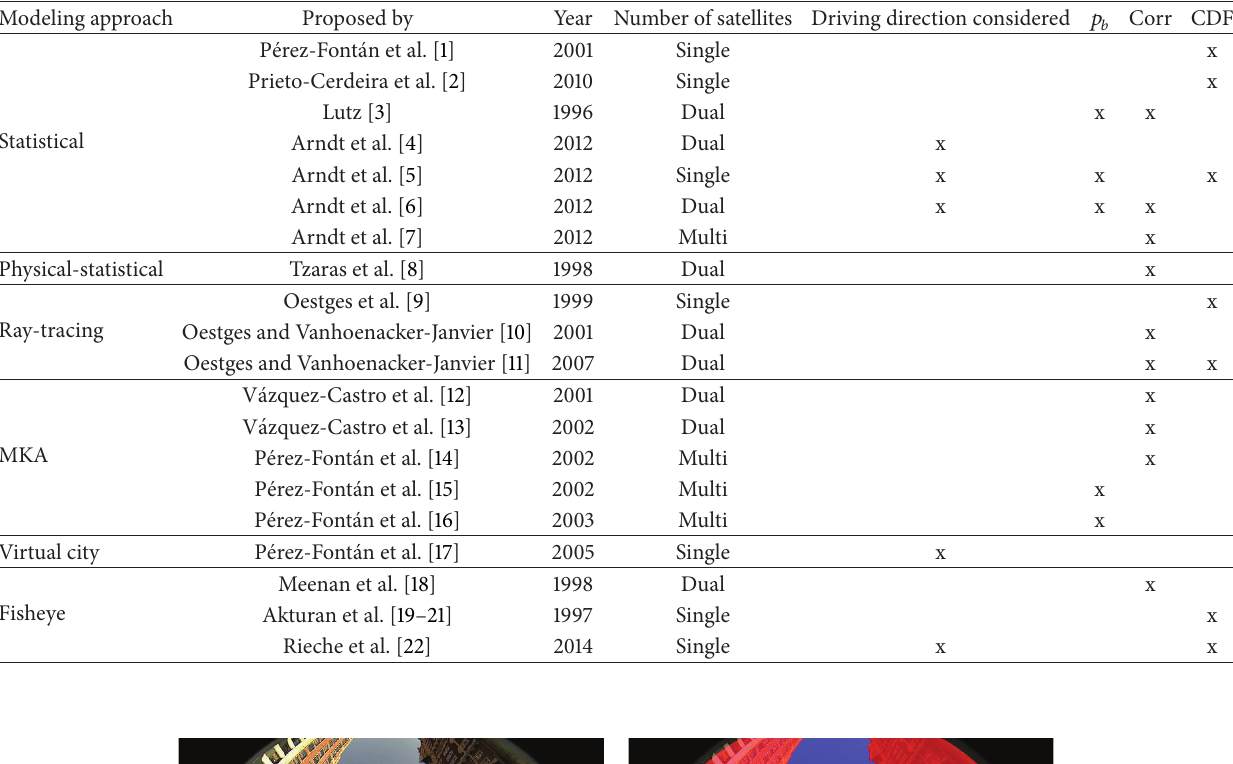
Table 1: Statistical and physical-statistical LMS channel models are compared with respect to the modeling approach, the number of satellites, considering the driving direction of the terminal, considering the correlation coefficient (Corr) and regarding the evaluation criteria cumulative distribution function (CDF) and the bad state probability of a satellite 𝑝 𝑏 .